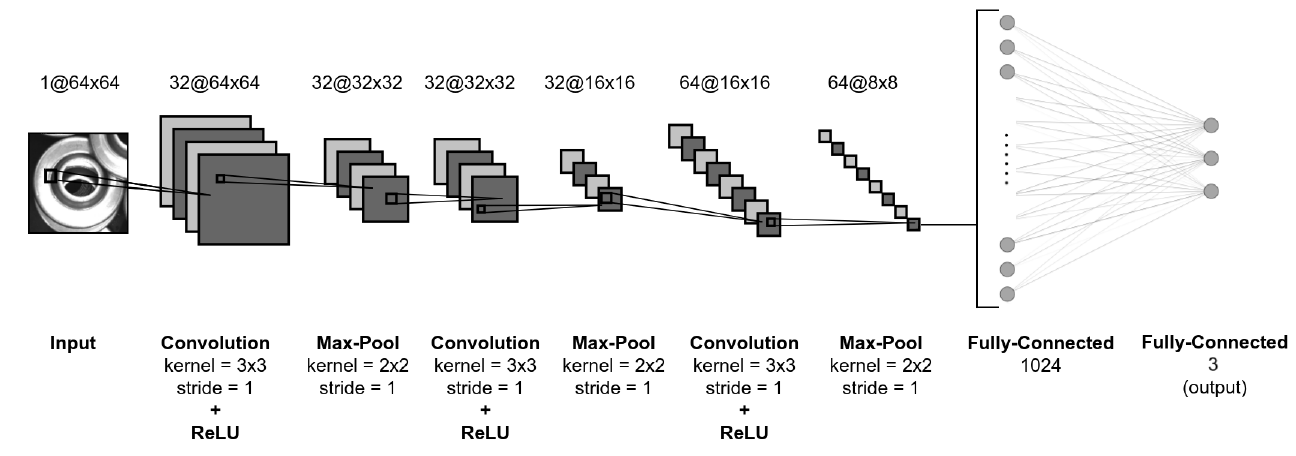
Figure 13. CNN architecture for occlusion detection.